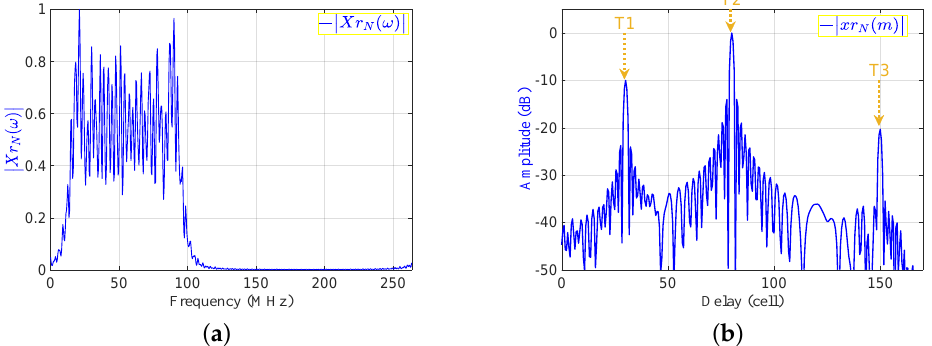
where X N function of the transmitted signal. 8. Applying IFFT to X N The absolutes of Xr N